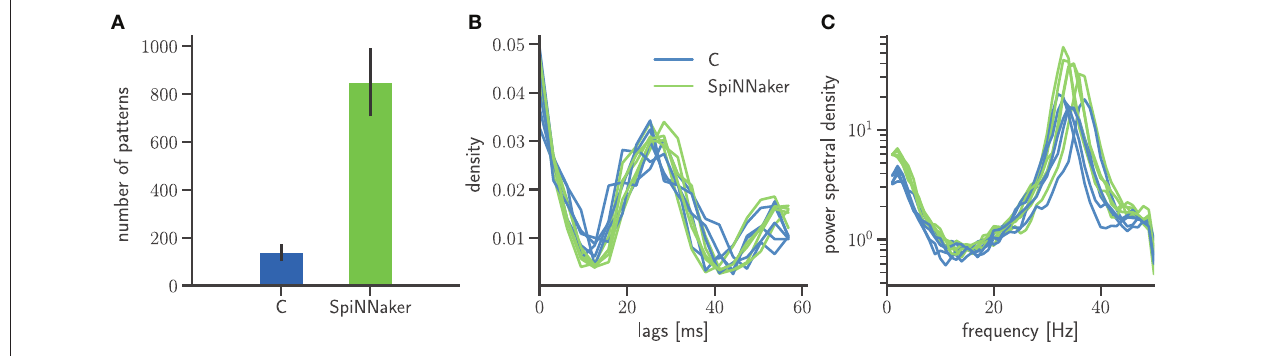
FIGURE 9 | Frequency and structure of spatiotemporal spike patterns. (A) Bar diagram of the number of patterns detected using the SPADE method (Quaglio et al., 2017) in the two simulations. Displayed are the mean and standard deviation of the results for the 5 network states. The spike times of all 800 excitatory neurons are discretized by 3 ms bins and only spike sequences that repeated 3 or more times, are formed by at least 5 spikes, and with a temporal length between first and last spike shorter than 60 ms are considered. (B) Normalized distributions of the temporal lags between any two spikes involved in one of the patterns. The results for each of the 5 network states are displayed as a separate distribution. (C) Power spectra of the population activity in each network state. The spectra are calculated by Welch’s method with a 100 Hz sampling frequency and a 1 Hz frequency resolution (window overlap: 50%). In all panels, data from the C and SpiNNaker simulations are indicated in blue and green,